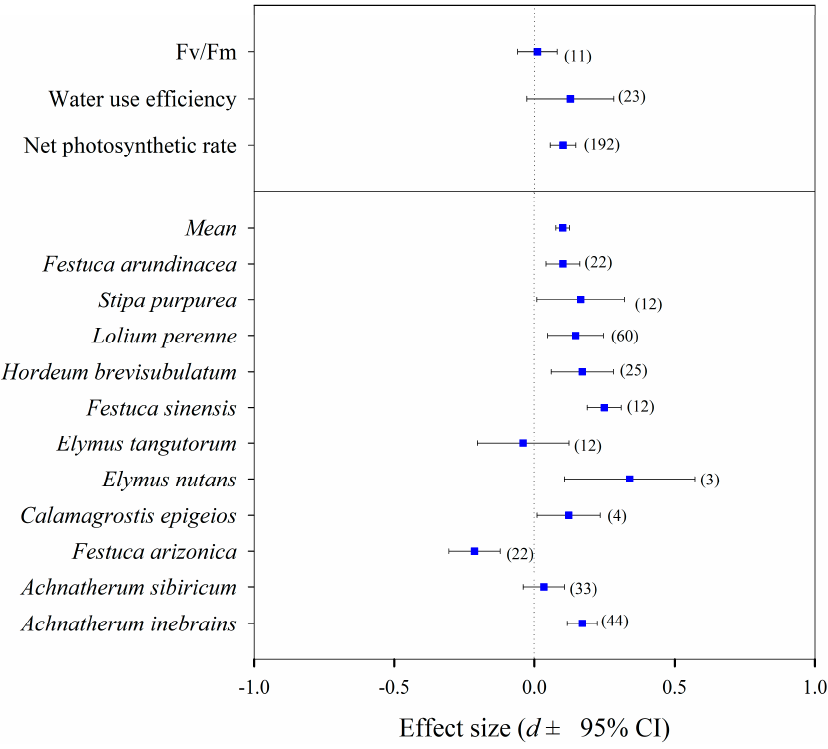
Figure 4. The effects of the symbiotic Epichloë fungal endophyte on the net photosynthetic efficiency (NPE), water use efficiency (WUE), and photochemical efficiency (Fv/Fm) of grasses (relative effects of Epichloë symbiotic versus non-symbiotic plants). Note: A total of 45 papers, including 14 papers in English and 31 papers in Chinese, were selected for this analysis. The number of studies analysed in each category are given in parentheses.